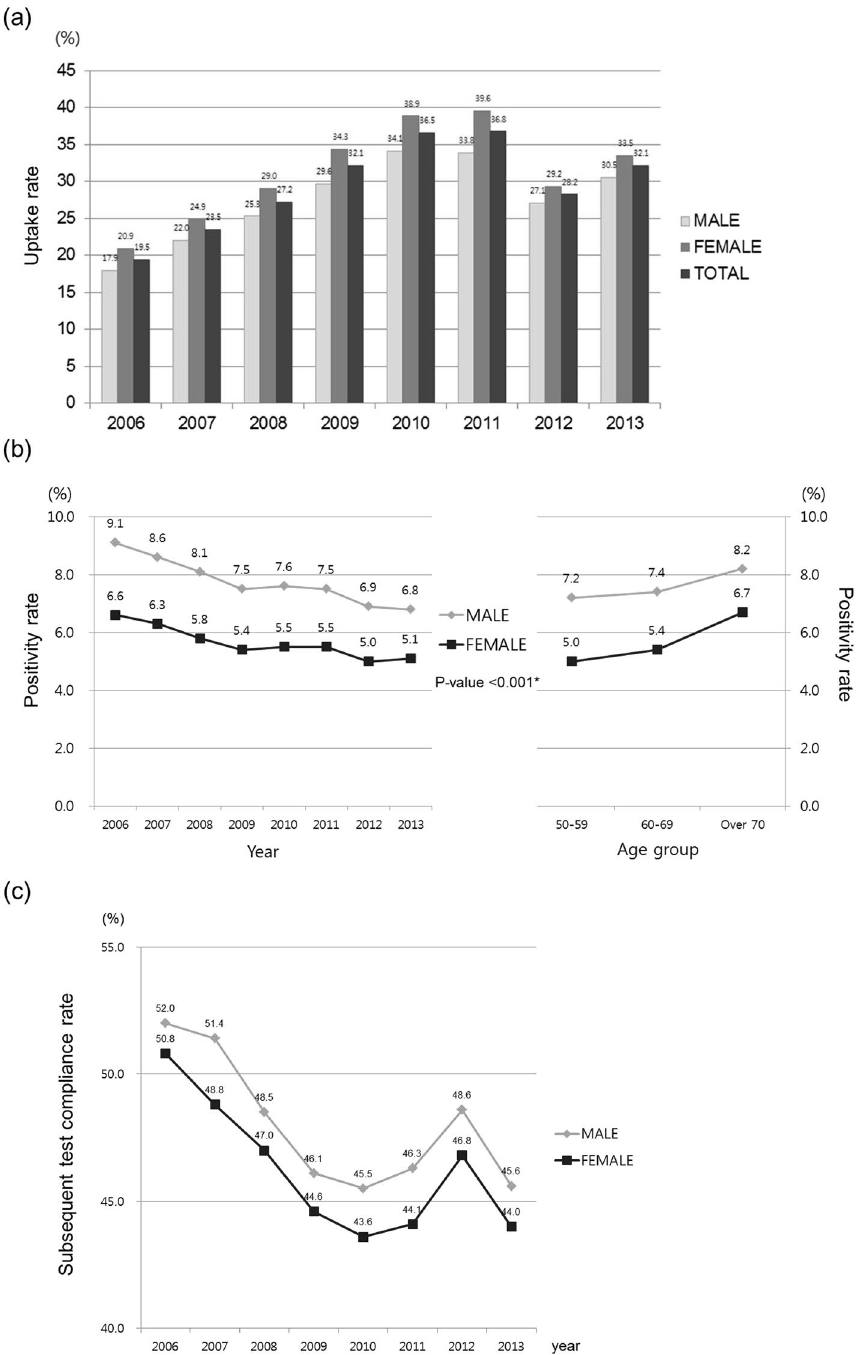
Figure 1. Trends of key indicators in the Korea national colorectal cancer screening program from 2006 to 2013. ( a ) Changes in uptake rates (%) of the fecal occult blood test by gender. Uptake rate (%) was calculated as follows; Number of fecal occult blood test participants/Number of eligible individuals for national colorectal cancer screening program. ( b ) Changes in fecal occult blood test positivity rates (%) by gender and age group. * Comparison of fecal occult blood test positivity rates between males and females and between age groups was performed each year using the Chi-square test. All P -values are < 0.001. Fecal occult blood test positivity rate (%) was calculated as follows; Number of positive fecal occult blood test results/Number of fecal occult blood tests performed. ( c ) Changes in subsequent test compliance rates by gender. Subsequent test compliance rate (%) was calculated as follows; Number of colonoscopy or double-contrast barium enema test procedures performed/Number of positive fecal occult blood test